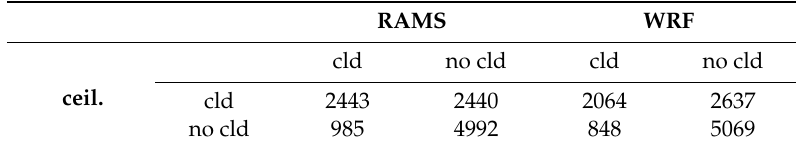
Table 2. Frequency distribution describing the number of cases when clouds were present or absent in both the model and the observations (ceil. for ceilometer).